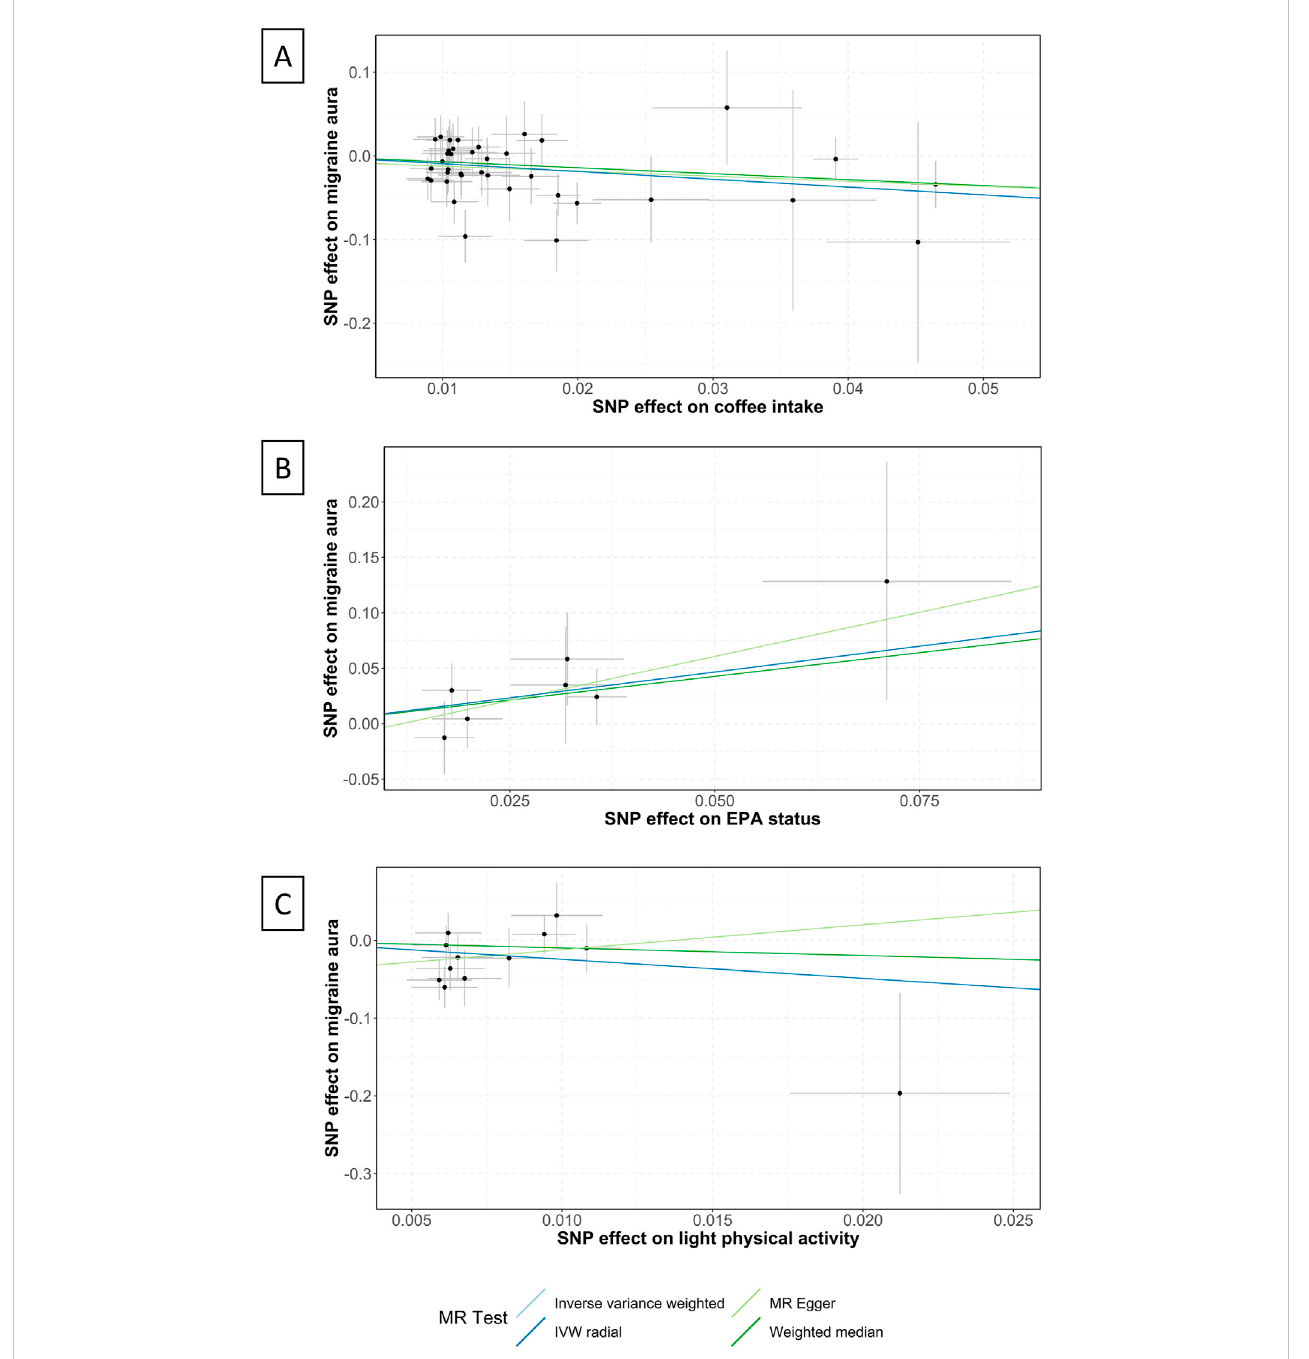
FIGURE 4 Scatterplotsoftheassociationbetweencoffeeintake,EPAstatus,lightphysicalactivityandmigrainewithaura.EPA,Eicosapentaenoicacid;IVW,inverse variance weighted; MR,Mendelianrandomization;SNP,single nucleotide polymorphisms.Annotation: Scatterplots ofthemigraine-SNPassociations( y -axis) versus theexposures-SNP associations ( x -axis)wereshown, with vertical and horizontal lines showing 95%con fi dence intervals. The fi ttedcurves among the dots refer to the differential statistical analysis methods. The MR analyses were performed with the inverse variance weighted method, the MR-Egger method, the weighted median method, and the IVW radial method. (A) shows the scatter plot of coffee intake, (B) shows EPA status, and (C) shows light physical